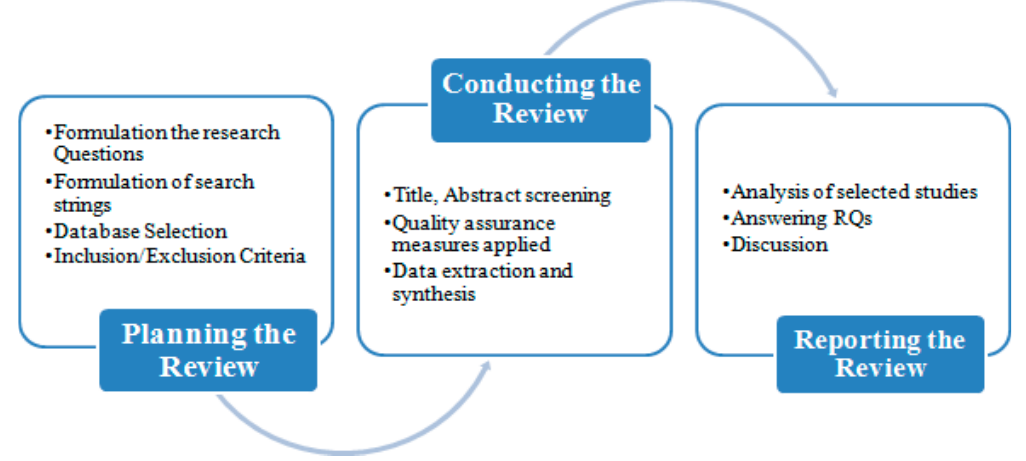
Figure 2. Research methodology (SLR Protocol).